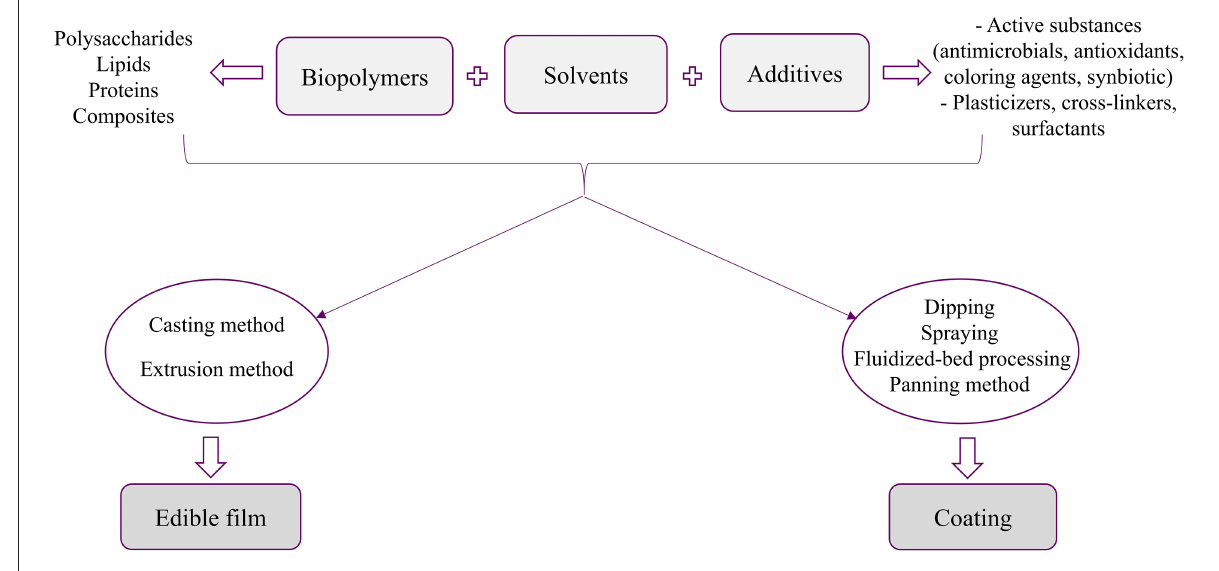
FIGURE2 Materials and methods for preparation of edible films and